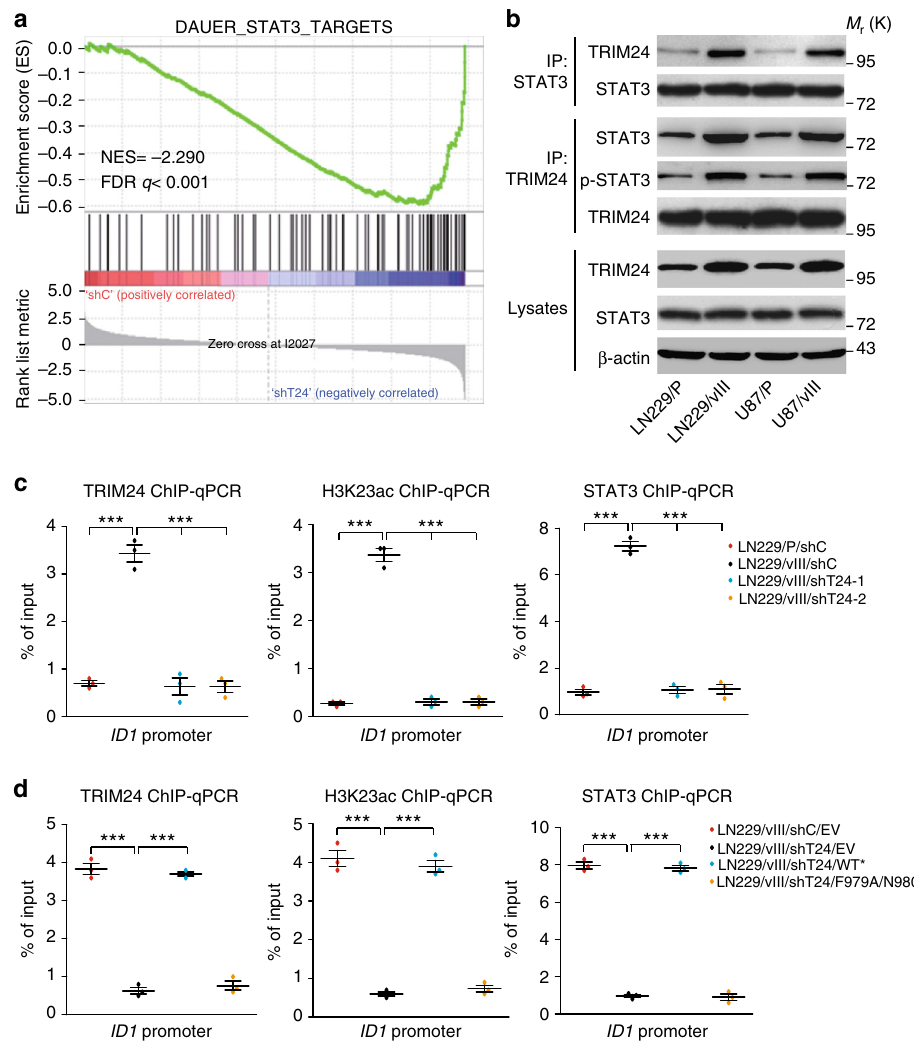
Fig. 6 TRIM24 functions as a co-activator and stabilizes STAT3-chromatin interactions. a Gene set enrichment analysis of STAT3 target genes 34 using ranked gene expression changes in TRIM24 knockdown LN229/EGFRvIII cells compare to control cells. NES, normalized enrichment score. b IP and WB analyses of TRIM24 and STAT3 expression and binding in LN229 and U87 GBM cells with, or without EGFRvIII overexpression. c ChIP-qRT-PCR analyses of the binding of TRIM24, STAT3 and H3K23ac with the ID1 promoter. d ChIP-qRT-PCR analyses of the effects of Flag-TRIM24 shRNA-resistant TRIM24 WT* , or TRIM24 F979A/N980A* mutant or an empty vector control (EV), on the binding of TRIM24, STAT3 and H3K23ac with ID1 promoter. Error bars, s.d. Data represent two or three independent experiments with similar results. *** P < 0.001, paired two-way Student ’ s t -test, compared with parental cells treated with shC or